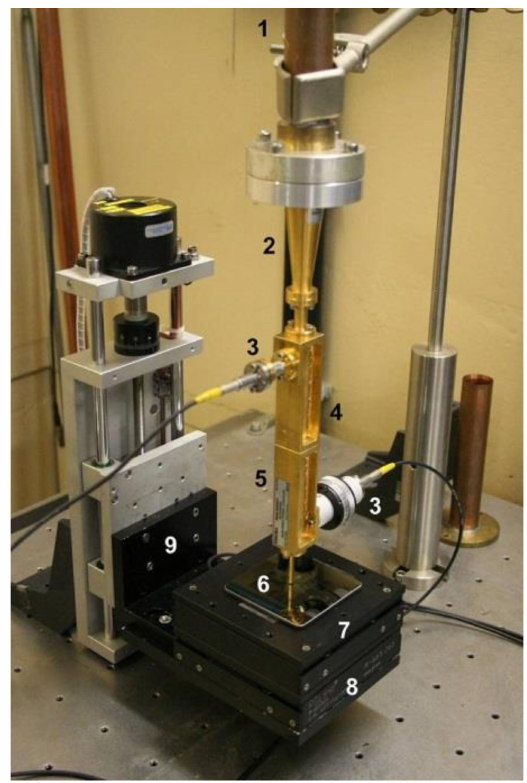
Figure 1. Layout of the terahertz (THz) imaging system: ( 1 ) Light-pipe. ( 2 ) Focusing cone. ( 3 ) Schottky diodes. ( 4 ) 10 dB directional coupler. ( 5 ) 20 dB directional coupler. ( 6 ) WR6 imaging probe. ( 7 ) Sample plane. ( 8 ) XY axes translational stage. ( 9 ) Z axis translational